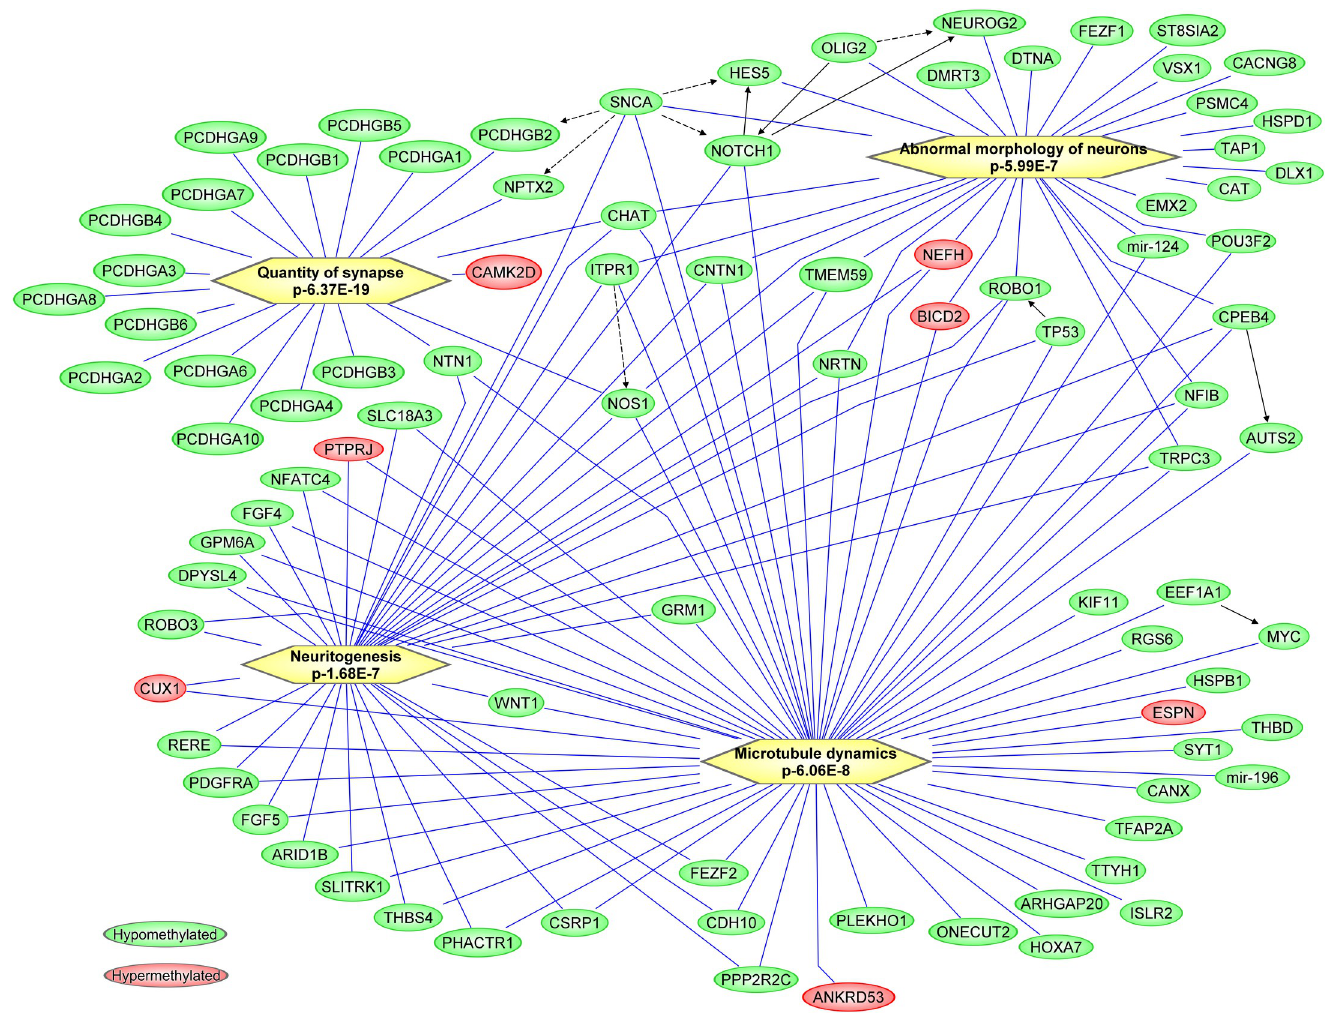
Fig 2. Ingenuity Pathway Analysis pathways analysis of significant DNA methylation variations and network analysis performed using Ingenuity Pathway Analysis (IPA).